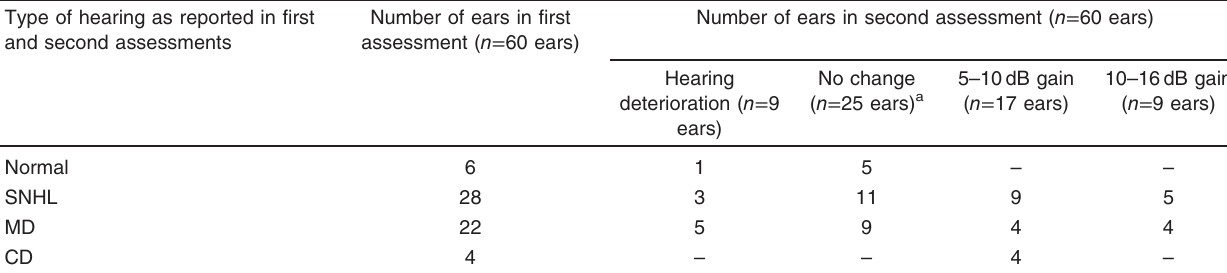
Table 7 Pure-tone audiometry findings of 60 ears at the final assessment after achieving an euthyroid state for 6 months Type of hearing as reported in first and second